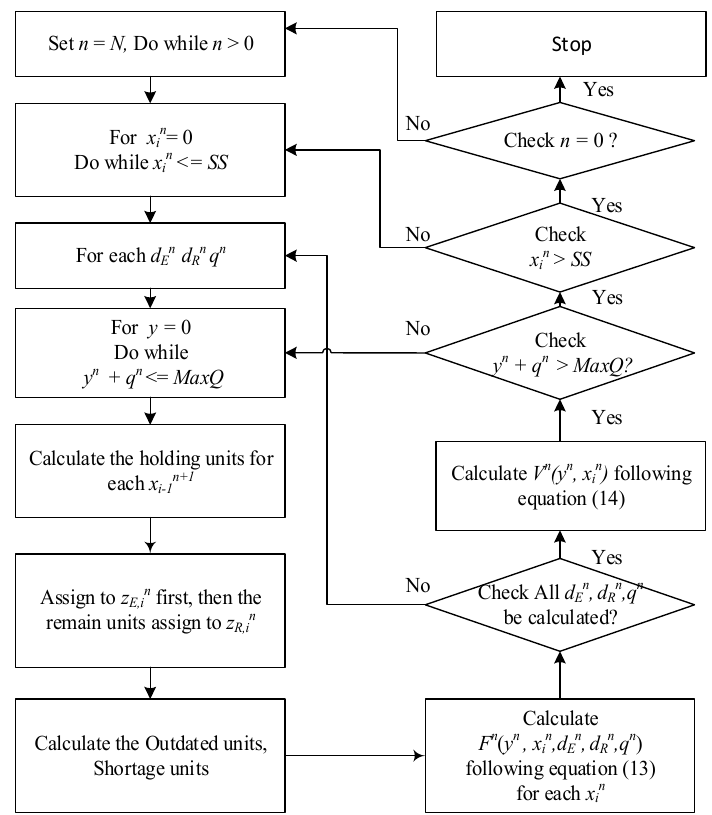
Fig. 3. Process flow to solve periodic blood inventory problem with two supplies and two priority demands by using DP